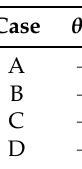
Figure 11. Overview of wheel sensor unit with a laser sensor. Table 3. Configuration of sensor position θ e , θ o , as shown in Figure